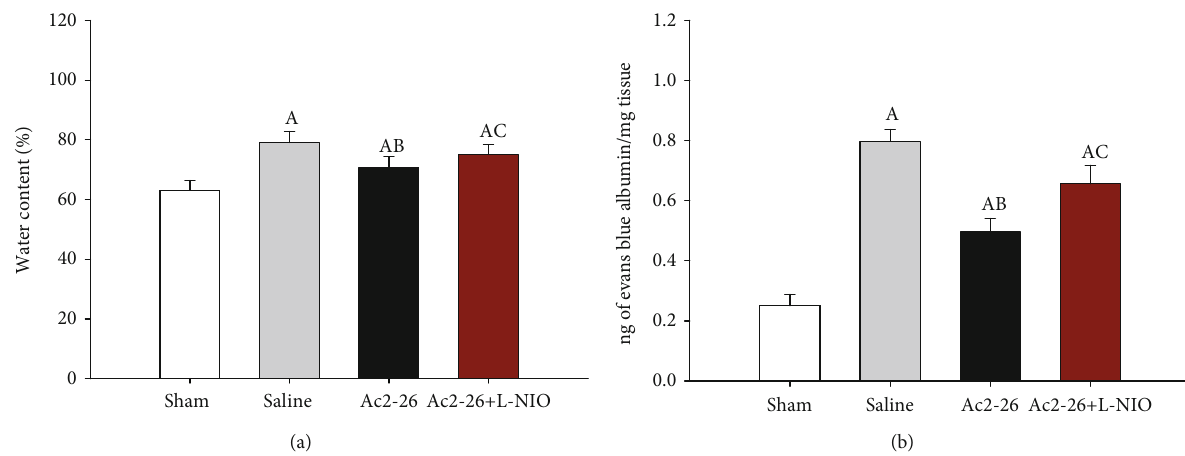
Figure 1: BBB integrity after ROSC. The wet/dry ratio (a) and levels of Evan ’ s blue dye (b) in the brain tissues were measured 72 hours after ROSC. Data are presented as mean ± SD . A P < 0 : 05 vs. sham group; AB P < 0 : 05 vs. saline group; AC P < 0 : 05 vs. Ac2-26 group (, sham group; , saline group; , Ac2-26 group; , Ac2-26+L-NIO